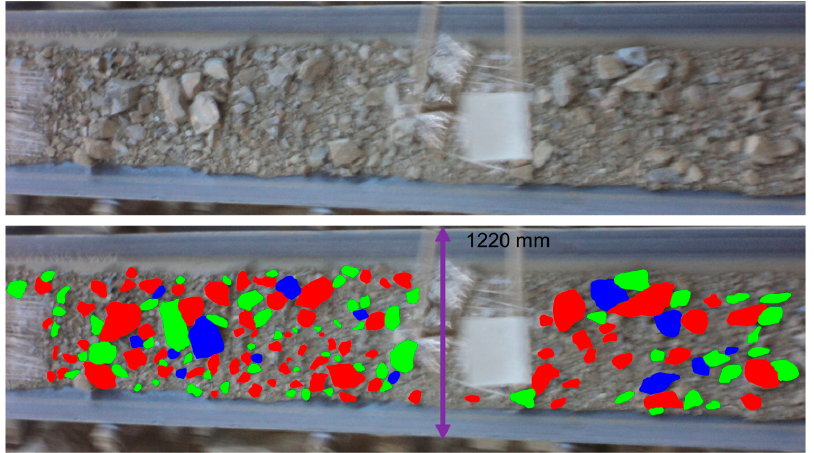
Figure 13. Manual marking on a conveyor belt (the width of the conveyor belt is represented in